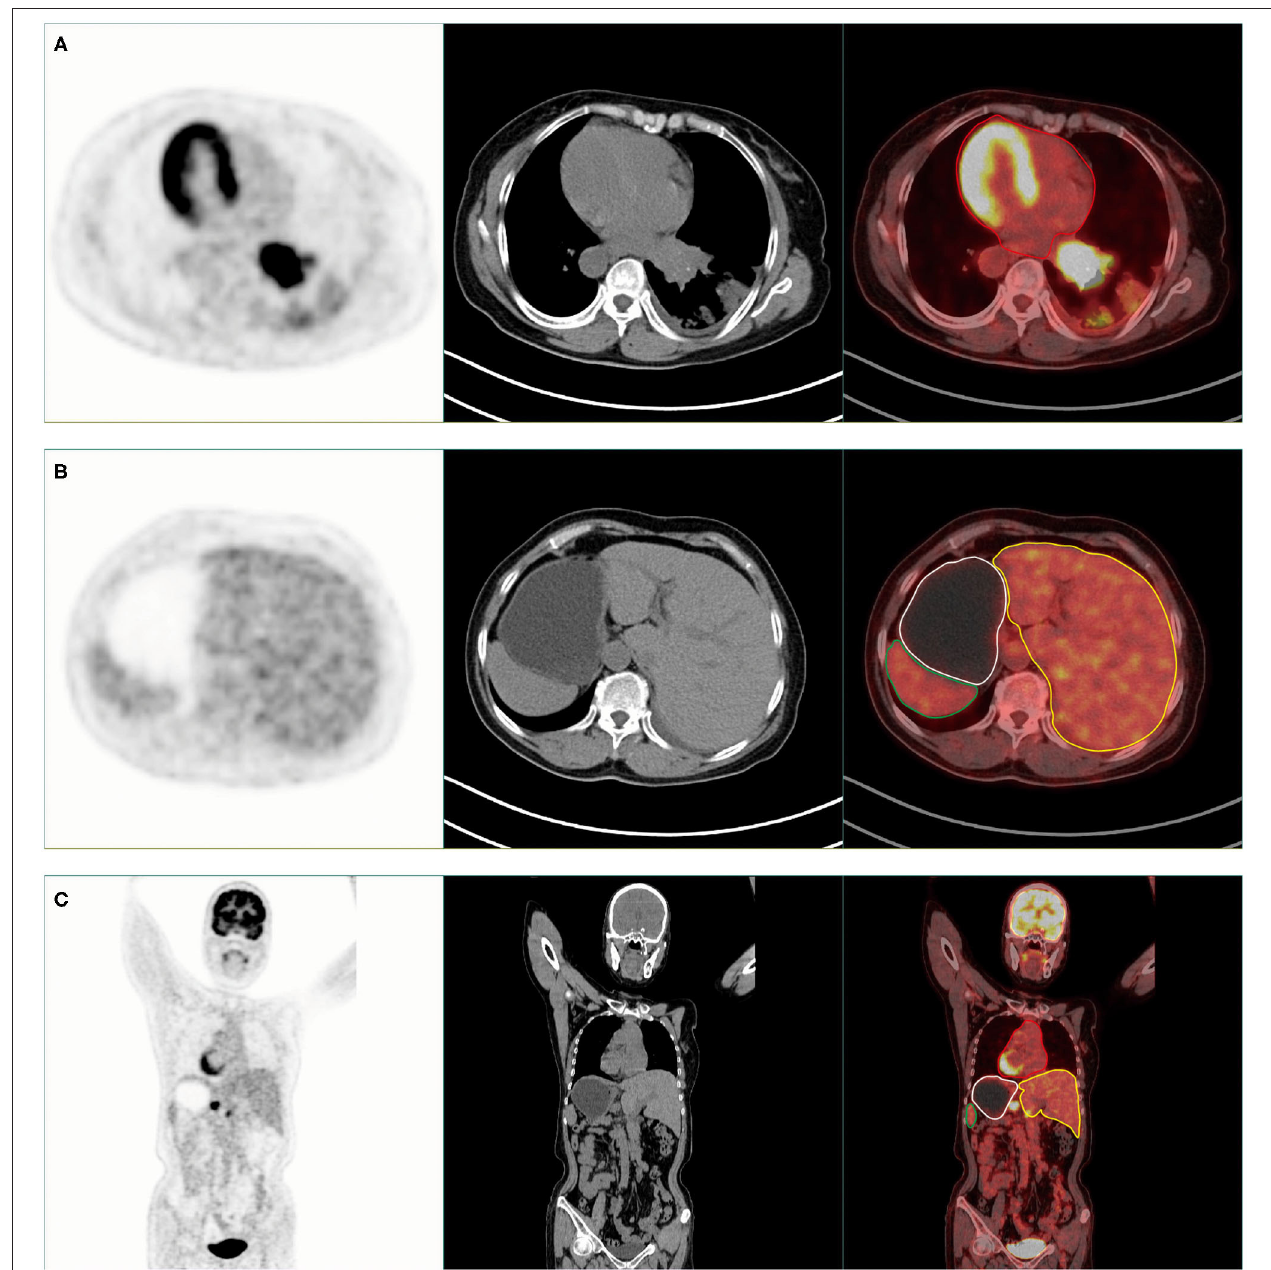
FIGURE 2 | PET/CT scan showed that this was a patient with situs inversus totalis (SIT). (A,B) Axial PET, CT, and PET/CT fusion images show the dextrocardia (red area), liver on the left side (yellow area), stomach (white area), and spleen (green area) on the right side of the patient’s body. (C) Coronal PET, CT, and PET/CT fusion images show the dextrocardia (red area), liver on the left side (yellow area), stomach (white area), and spleen (green area) on the right side of the patient’s